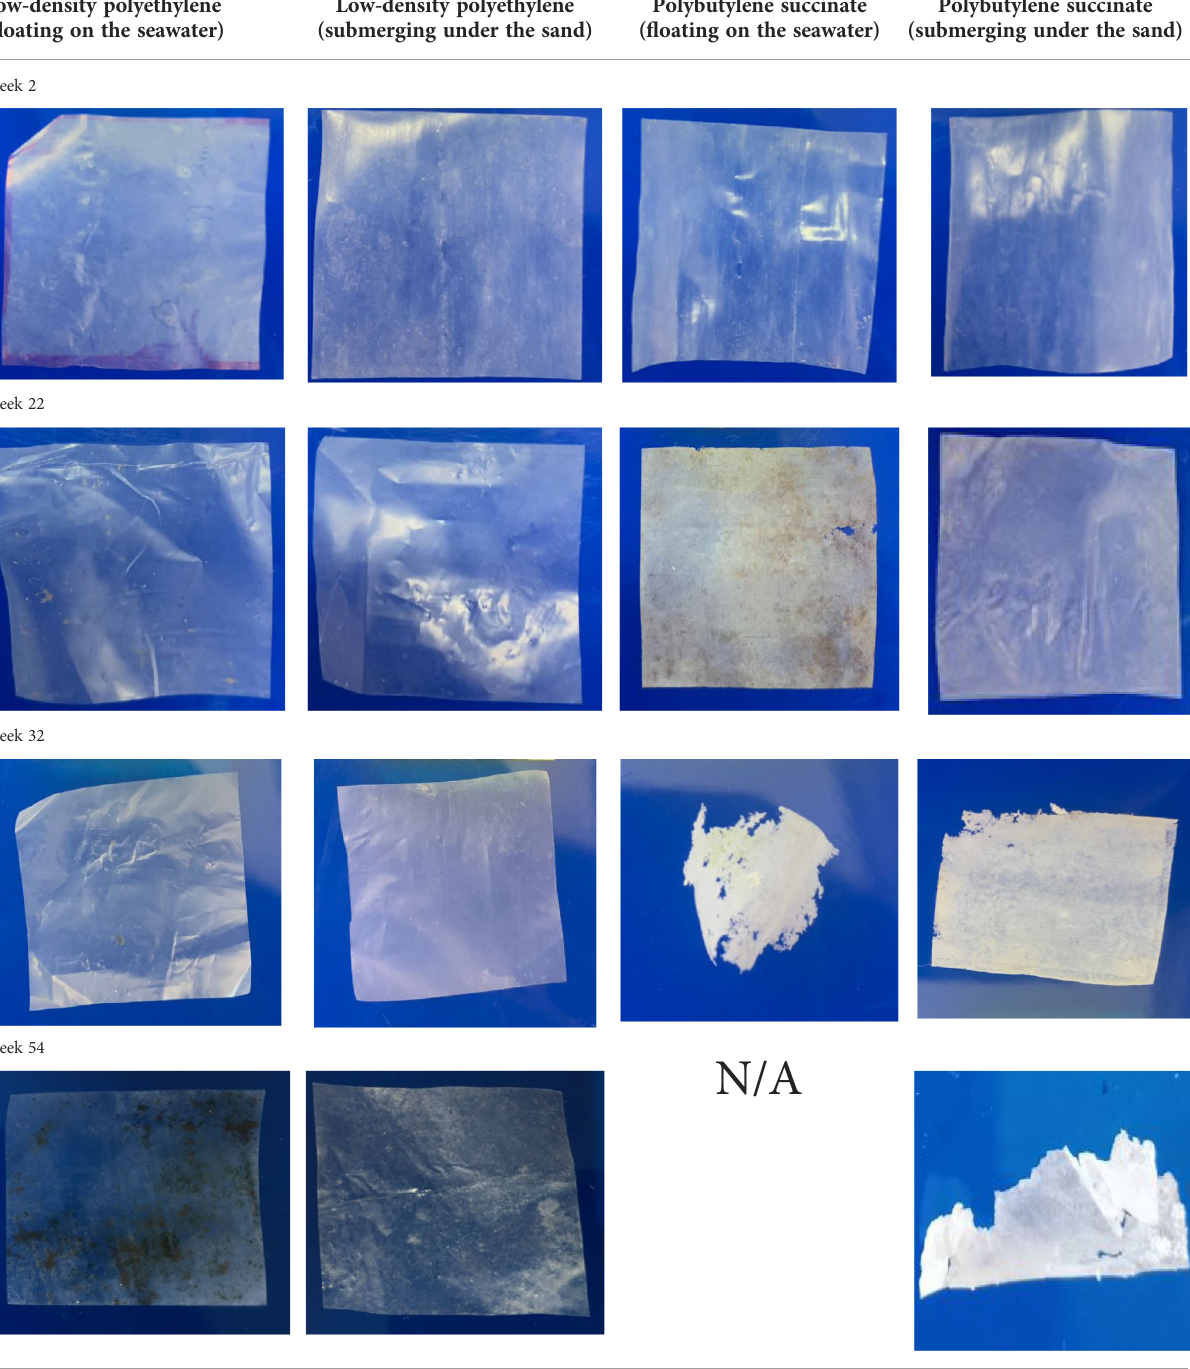
TABLE 1 Observation of blown fi lm that was fl oated on the seawater surface and submerged in the sand under the seawater of low-density polyethylene and polybutylene succinate. Low-density